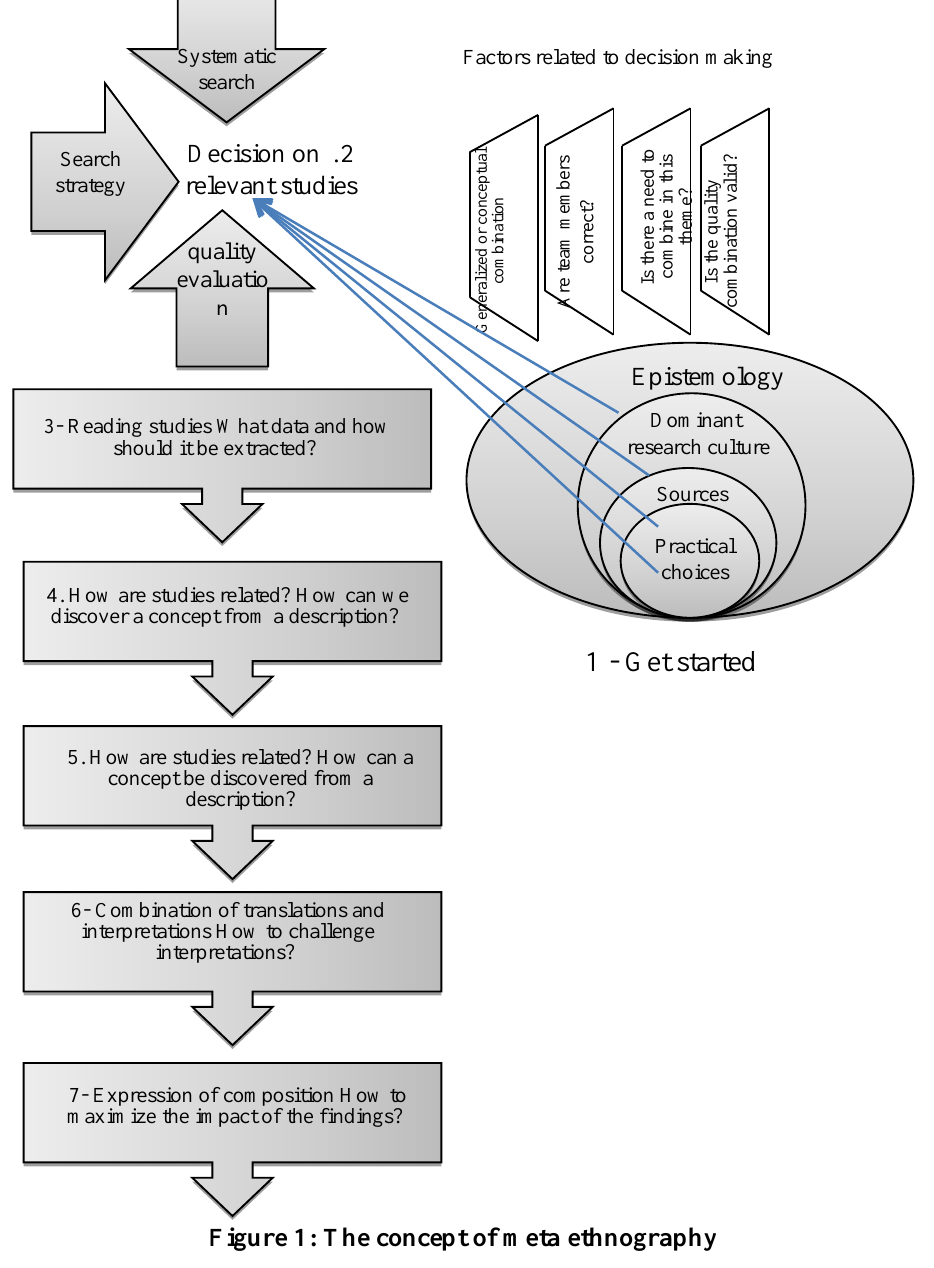
Figure 1: The concept of meta